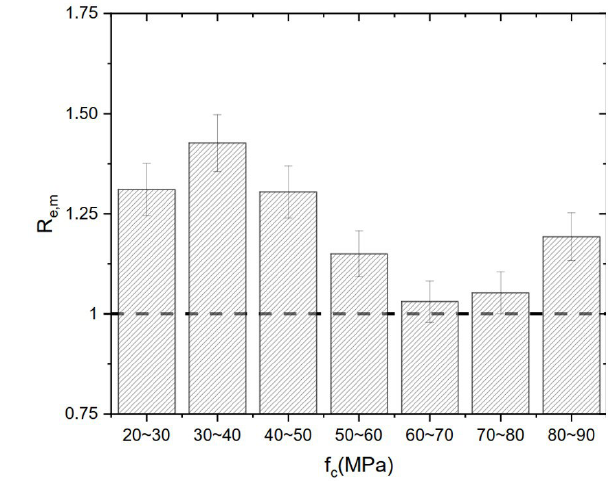
Figure 4. Average results of the application of the adjustment function in relation to